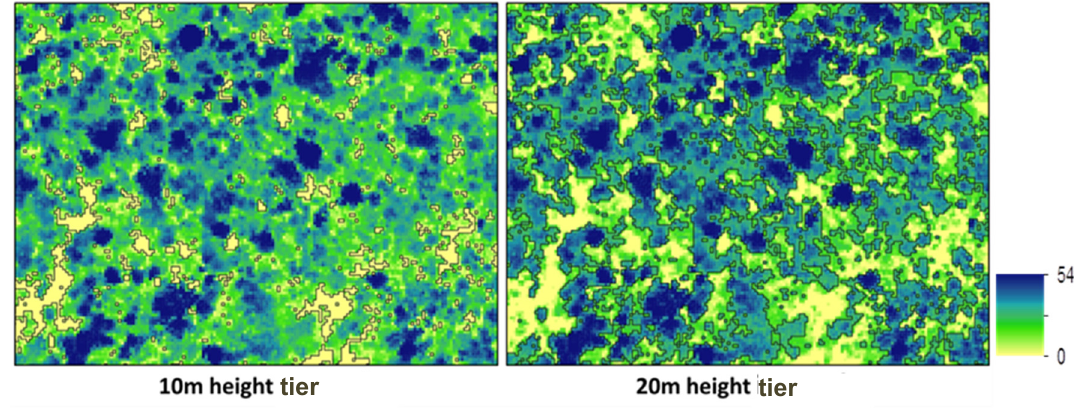
Figure 2. A section of the forest in Gola, represented by LiDAR-derived CHM, showing gaps (delineated by dark line) at the 10 m height tier ( left ) and 20 m height tier ( right ), in the same location. Cold colors represent taller canopy and warm colors represent shorter